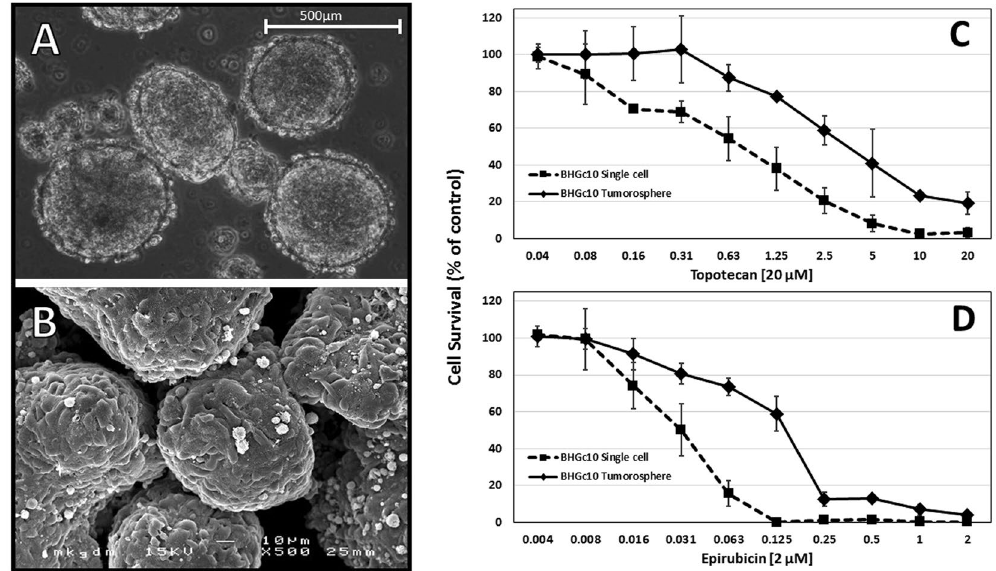
Figure 2. Light and scanning electron microscopy and chemosensitivity of CTC tumorospheres. ( A and B ) show light and SEM images of BHGc26 tumorospheres, respectively; ( C and D ) a comparison of the chemosensitivities to topotecan and epirubicin of BHGc10 single cells and tumorospheres in MTT assays, respectively (For the cytotoxicity assays, measurements are shown as mean values ±